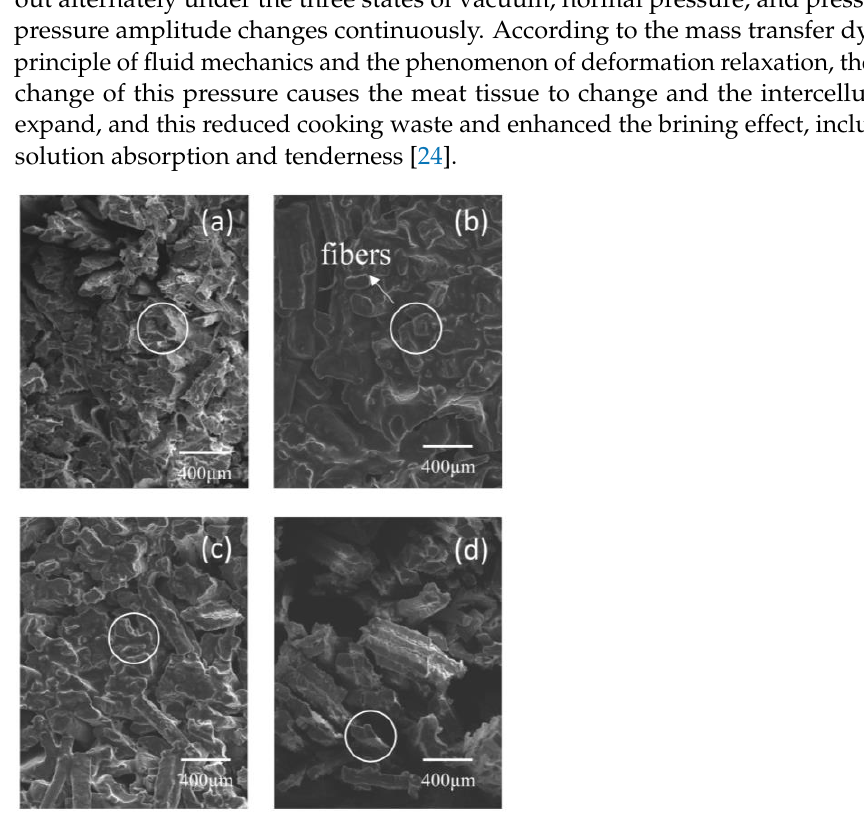
Figure 4. Effects of different curing methods on muscle fiber of beef. ( a ) SC; ( b ) VC; ( c ) PC; ( d ) PPC. SC = static curing, VC = vacuum curing, PC = pressurized curing, PPC = pulsed pressure curing.